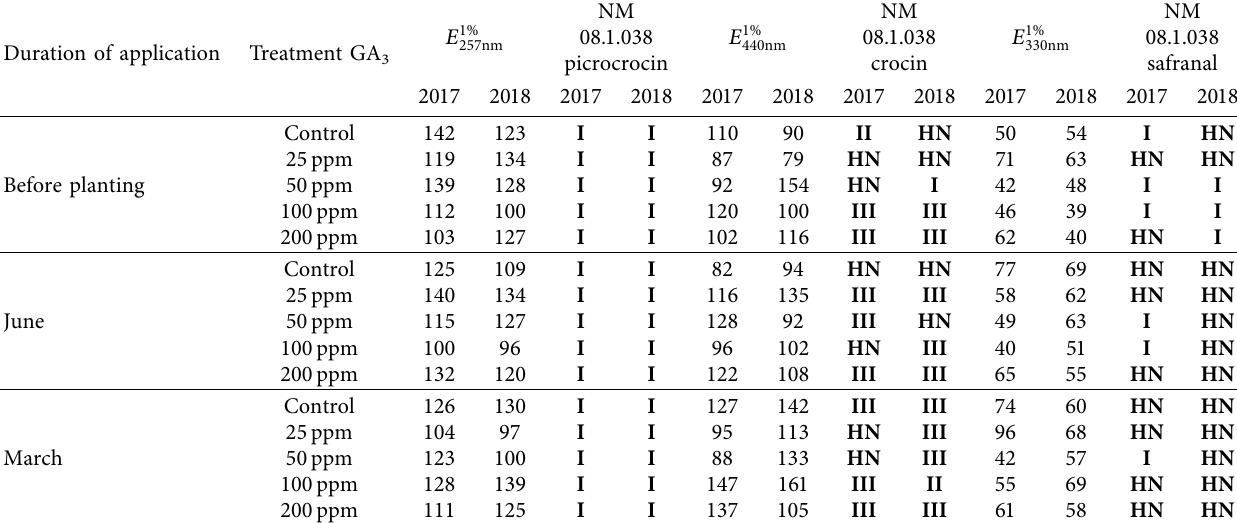
Table 3: Effect of different GA 3 concentrations and duration of application on phytochemical indices and quality grading of saffron stigmas. Duration of application